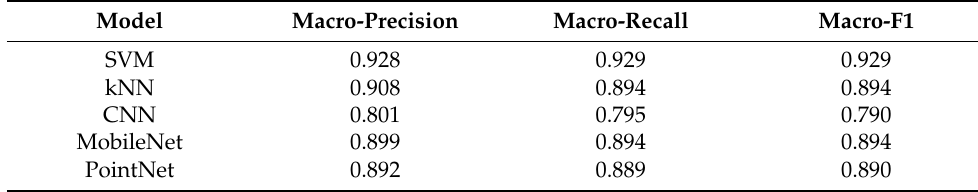
Table 2. Measures to evaluate the model performance.